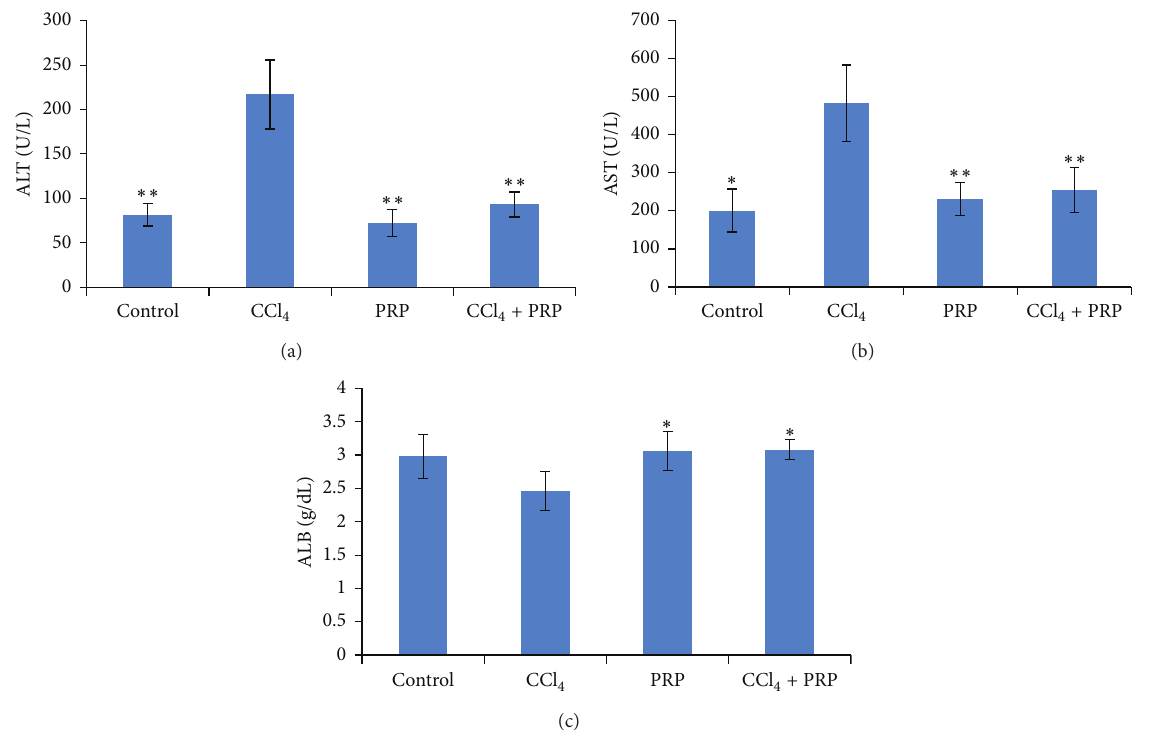
Figure 2: Effect of platelet rich plasma (PRP) on rat hepatic enzymes and albumin levels changed by CCl 4 . (a) ALT, (b) AST, (c) albumin. Rats were injected CCL 4 with doses (0.5mL/kg i.p. 1: 1 in olive oil) twice per week for 8 weeks. Five weeks after CCl 4 injection rats received PRP (0.5 mL/kg s.c.) 2 days a week for 3 weeks. Values are mean ± SD of 6 rats per group. ∗ Significantly different from CCl 4 -treated group ( 𝑃 ≤ 0.05 ). ∗∗ Significantly different from CCl 4 -treated group ( 𝑃 ≤ 0.01 ).